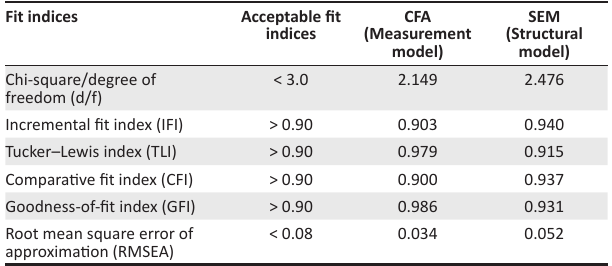
TABLE 4: Model-fit